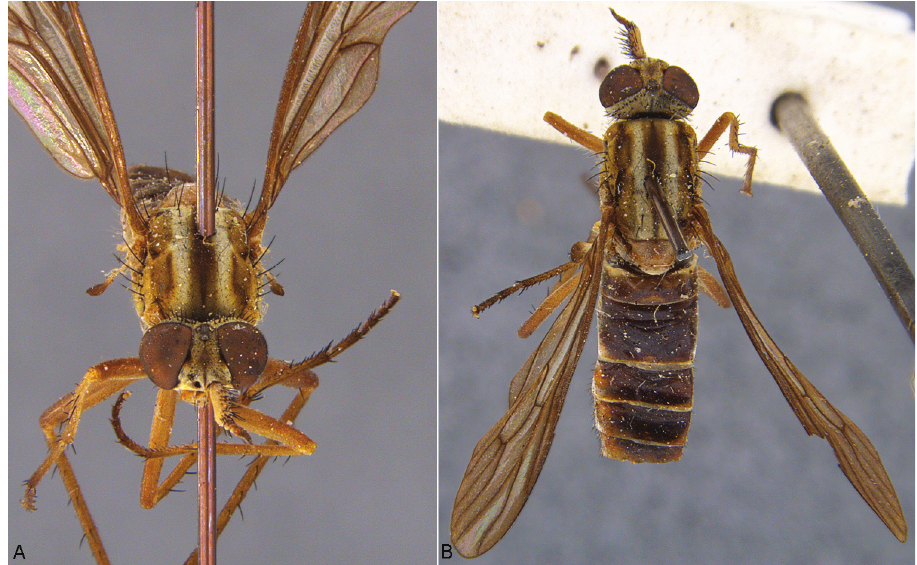
Figure 8. Sidarena flavipalpa sp. n.: A Female, anterior view B same, dorsal view. especially on anterior segments. Male terminalia . (Fig. 9) Epandrium longer than wide, with medium length black setae over entire surface; hypoproct rounded apically; gono- coxite ovate, outer gonocoxal process elongate and rounded, reaching half the distance to the tip of the inner gonocoxal process; inner gonocoxal process slightly spatulate